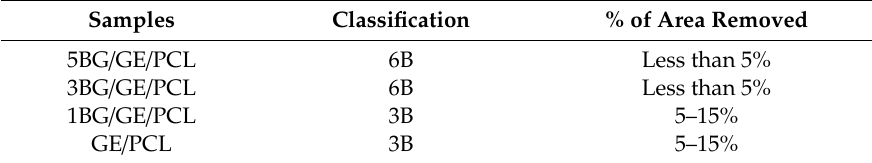
Table 3. The adhesion strength of different samples.